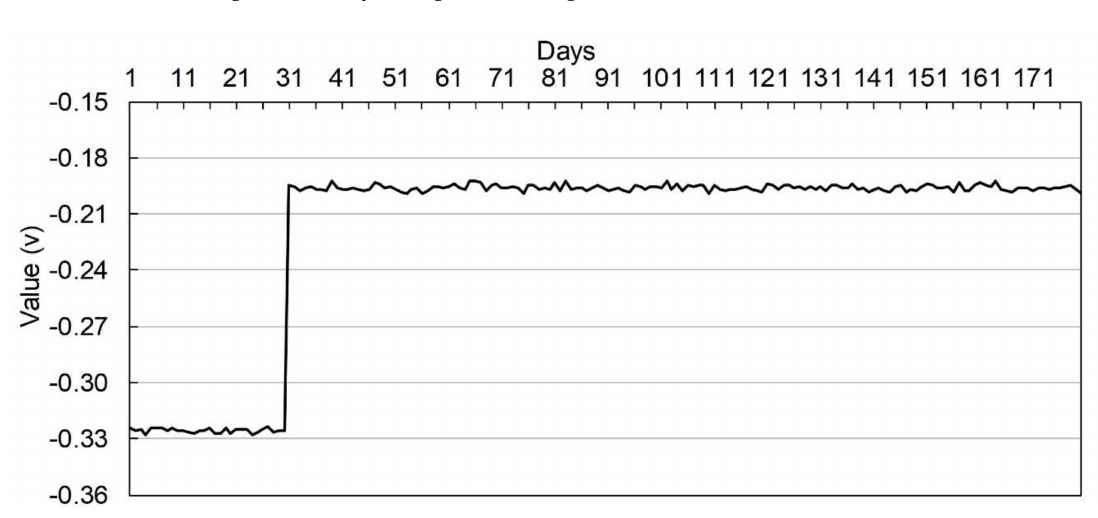
Figure 6. Changes in value v if a construction is blocking one route for agent Bob. The x-axes shows the days, and the y-axes show the value function.